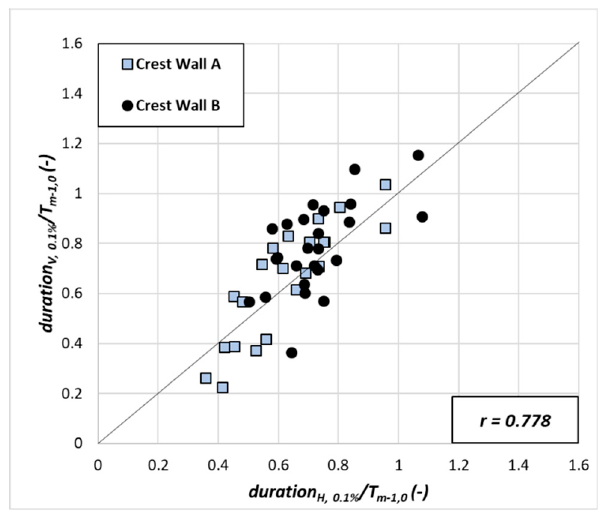
Figure 11. Comparison between the measured dimensionless duration 0.1% ( duration 0.1% / T m − 1,0 ) for horizontal and vertical